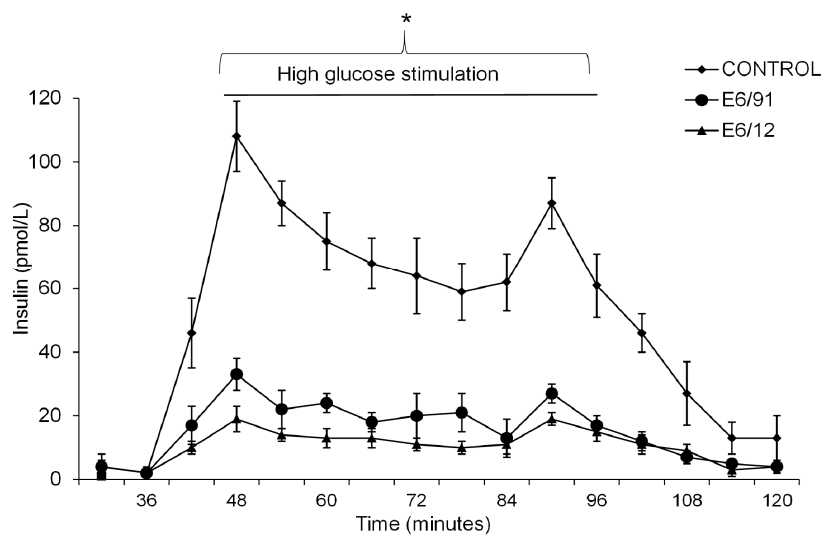
Figure 5. Dynamic release of glucose-stimulated insulin secretion in E6-infected islets. Fifty hand-picked and size-matched islets from three donors were infected with E6/91 and E6/12. Mock-infected islets were left as a negative control. On day three after infection, the islets were perifused with glucose (1.67 mmol/L, 16.7 mmol/L, and 1.67 mmol/L). Fractions were collected at six-minute intervals and the secreted insulin was measured by enzyme-linked immunosorbent assay (ELISA). Data are presented as means ± SD and are based on observations from at least three donors. * p < 0.05 between groups (minutes 42 to 102).